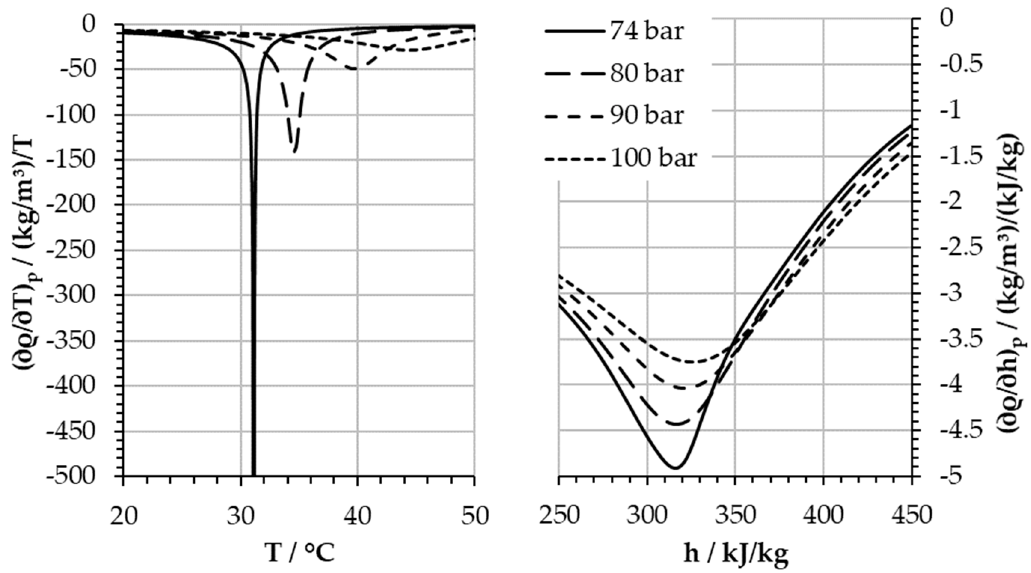
(cid:16) ∂ ρ (cid:17) (cid:4673) ( left ) and (cid:4672) (cid:2986)(cid:2977) ( left ) and ∂ T (cid:4673) (cid:2986)(cid:2904) ( left ) and (cid:4672) (cid:2986)(cid:2977) p (cid:2926) (cid:2986)(cid:2904) (cid:2926)